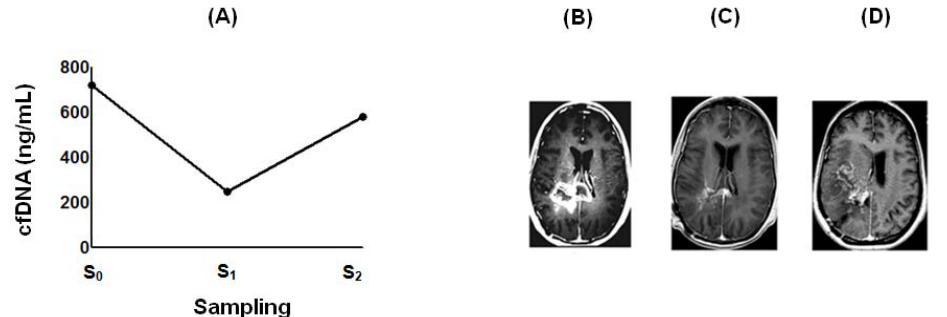
Figure 7. Figure depicts the effect of interrupting ITN-POH therapy. Intense signal with brain MRI ( B ) at the time of a GBM patient protocol enrollment correlated with high serum levels of circulating cfDNA ( A , S 0 = 720 ng/mL, November 2009). The therapy resulted in a three-fold decrease of cfDNA levels ( A , S 1 = 247 ng/mL, November 2012) and marked tumor mass reduction ( C ), but images of tumor recurrence ( D ) and a sharp increase of cfDNA serum levels ( A , S 2 = 580 ng/mL; February 2013) were simultaneously identified after 3 months of therapy discontinuation.